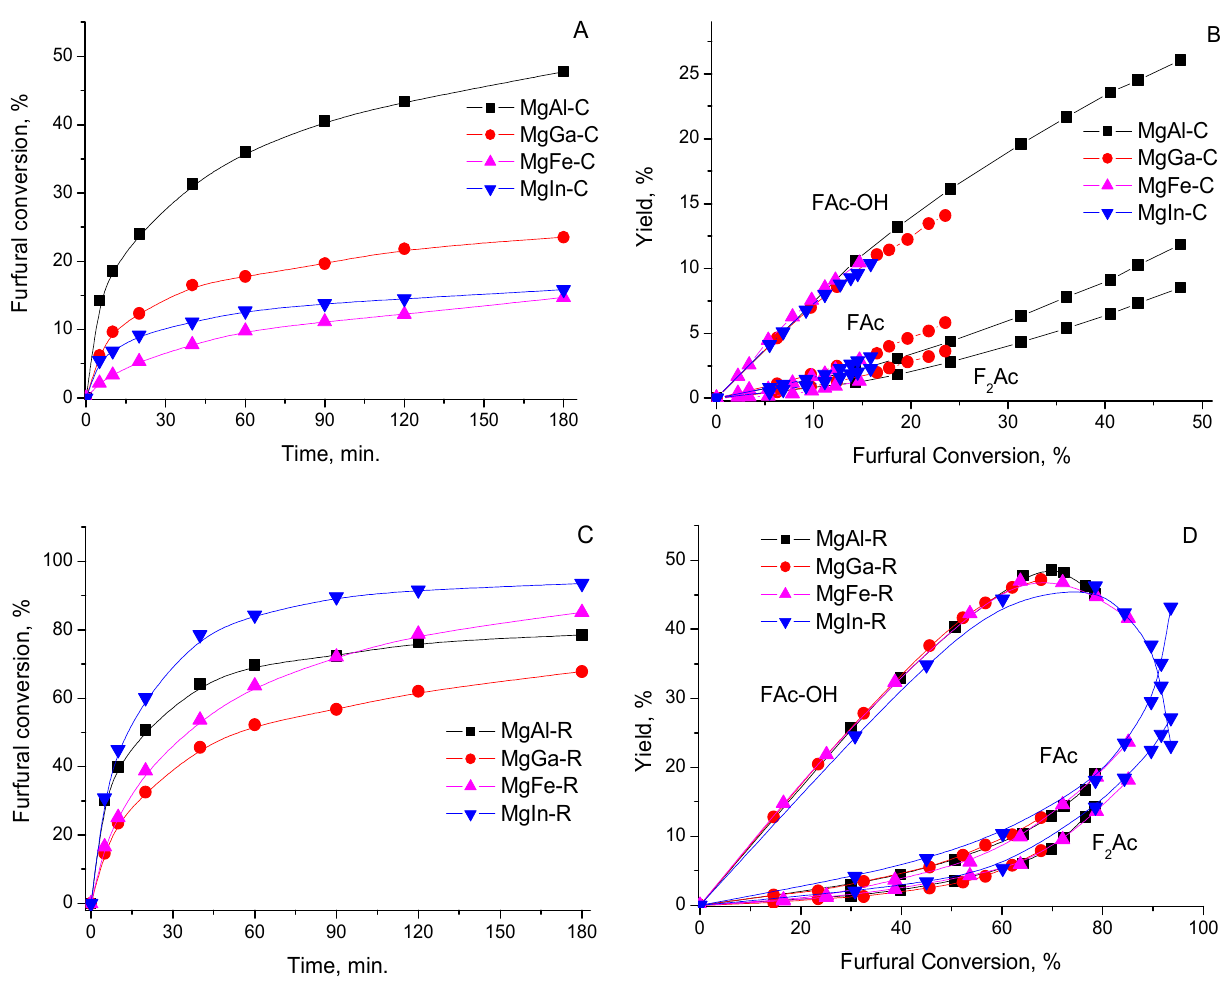
Figure 3. The dependence of the furfural conversion on the reaction time observed on MgM-C (( A ), T reac. = 50 ◦ C, molar ratio F:Ac = 1:10) and MgM-R ( C ), T reac. = 25 ◦ C, molar ratio F:Ac = 1:5) samples. Yield for the reaction products is observed on MgM-C ( B ) and MgM-R ( D ) as a function of the furfural conversion.